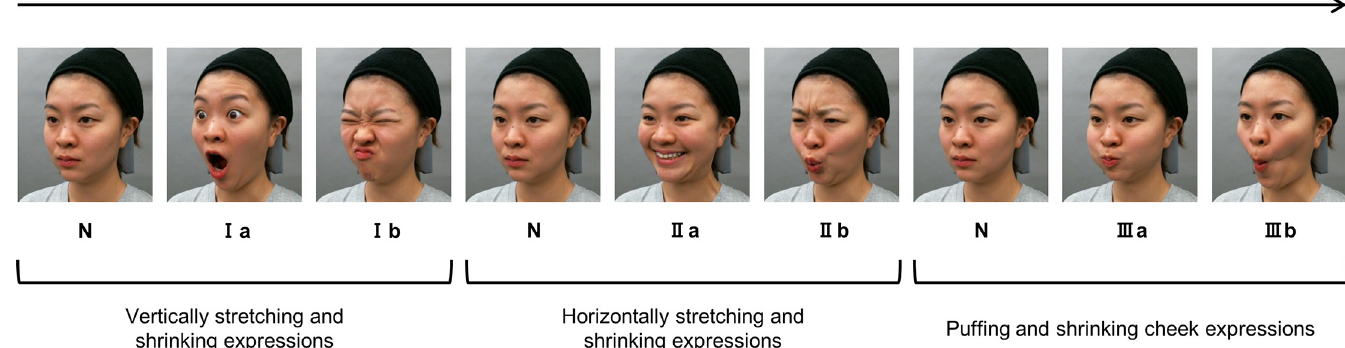
Fig 1. Facial expression sequence used as stimuli. Photograph N shows neutral facial expression; Ia, lowering chin with opening mouth expression; Ib, vertically shrunk facial expression; IIa, horizontally opening mouth expression; IIb, horizontally closing mouth expression; IIIa, puffing cheek expression; IIIb, shrinking cheek expression. The roman numerals I, II, and III indicate vertically stretching and shrinking mouth expressions, horizontally stretching and shrinking mouth expressions, and puffing and shrinking cheek expressions, respectively. The facial expressions changed every second. The long arrow over the facial photographs shows the stream of time.